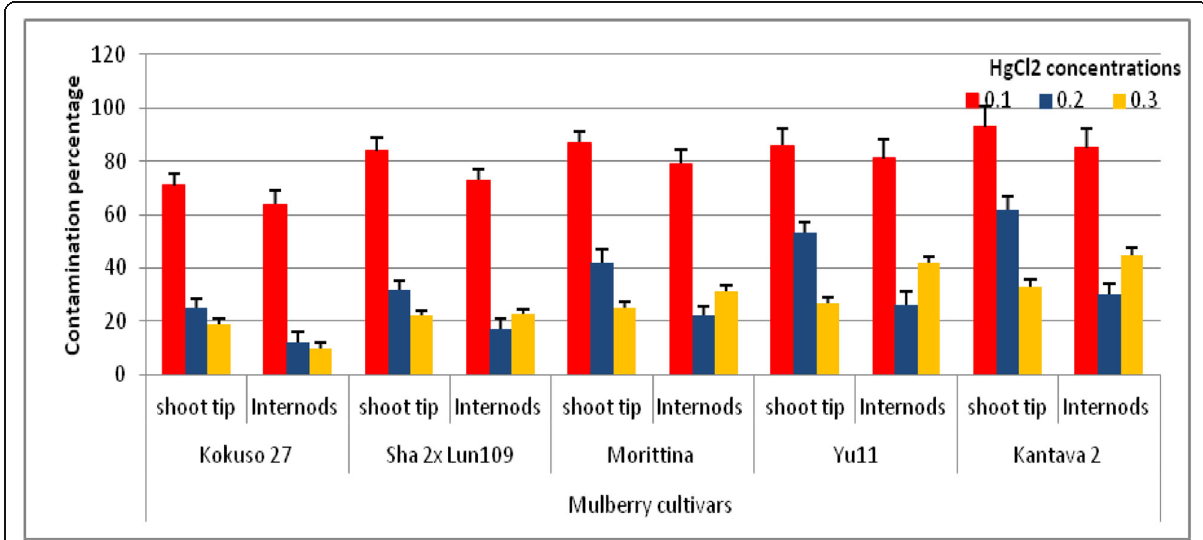
Fig. 1 Effect of sterilization treatments with HgCl2 (MC) at different concentrations (0.1, 0.2, and 0.3%) on the percentage of contamination. Shoot tips and internodes of different mulberry cultivars were used as